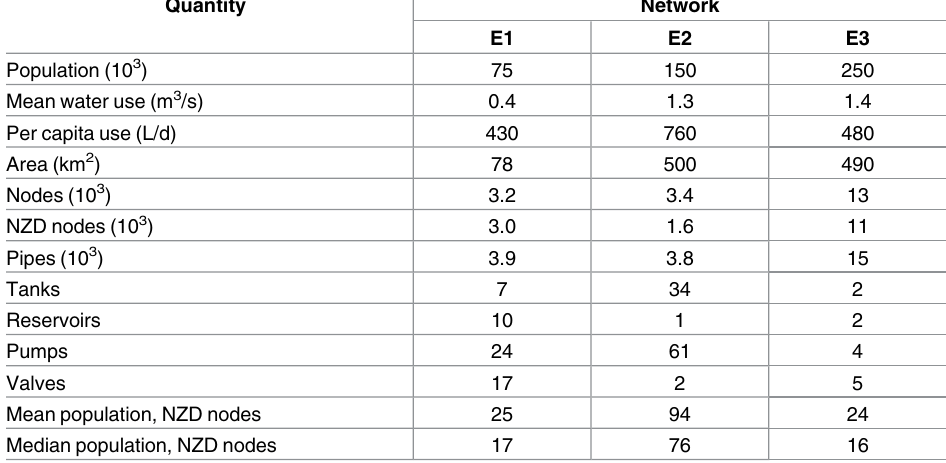
Table 5. Network